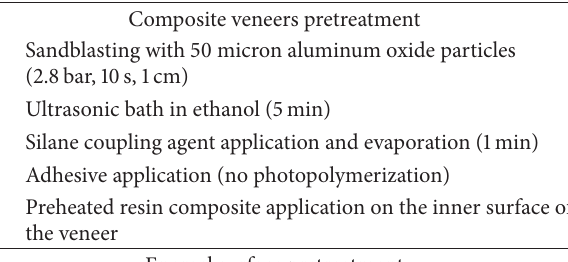
Table 1: Conditioning sequences for tooth and restoration